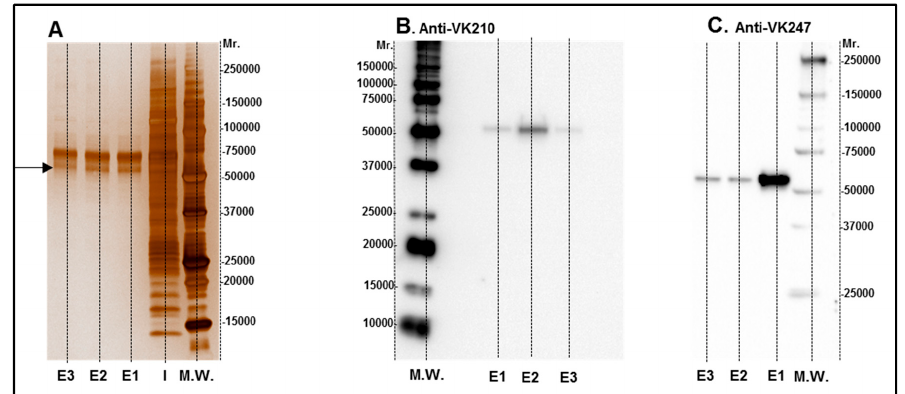
Figure 1. Images of rPvCSPc in silver staining ( A ) and Western blot ( B , C ). Elution samples after IMAC purification were submitted to 12.5% SDS-PAGE under reducing conditions and proteins were visualized with Silver stain ( A ). Lane I: Input of sample. E1 to E3 elution fractions were selected for SEC purification and tested with Western blot analyses using monoclonal antibodies for VK 210 ( B ) and VK 247 ( C ).